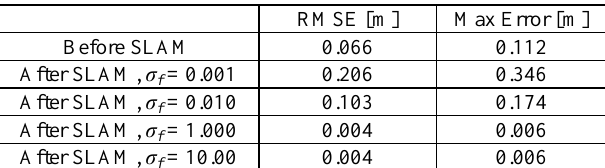
Table 2: Error in estimated trajectory when using the wrong σ f